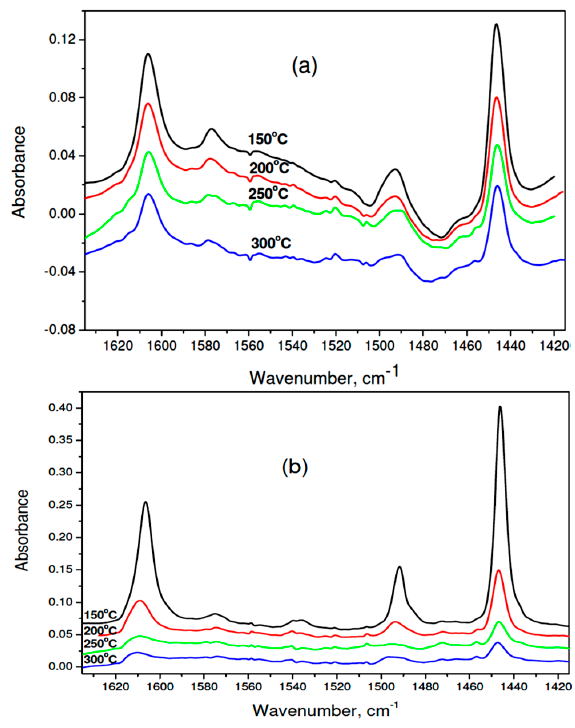
Figure 8. IR spectra of adsorbed pyridine on 1 wt % Pd/37MgO-63MgF 2 catalyst: ( a ) after reduction, ( b ) after CCl 4 hydrodechlorination. Numbers ascribed to spectra indicate the temperature of pyridine desorption.